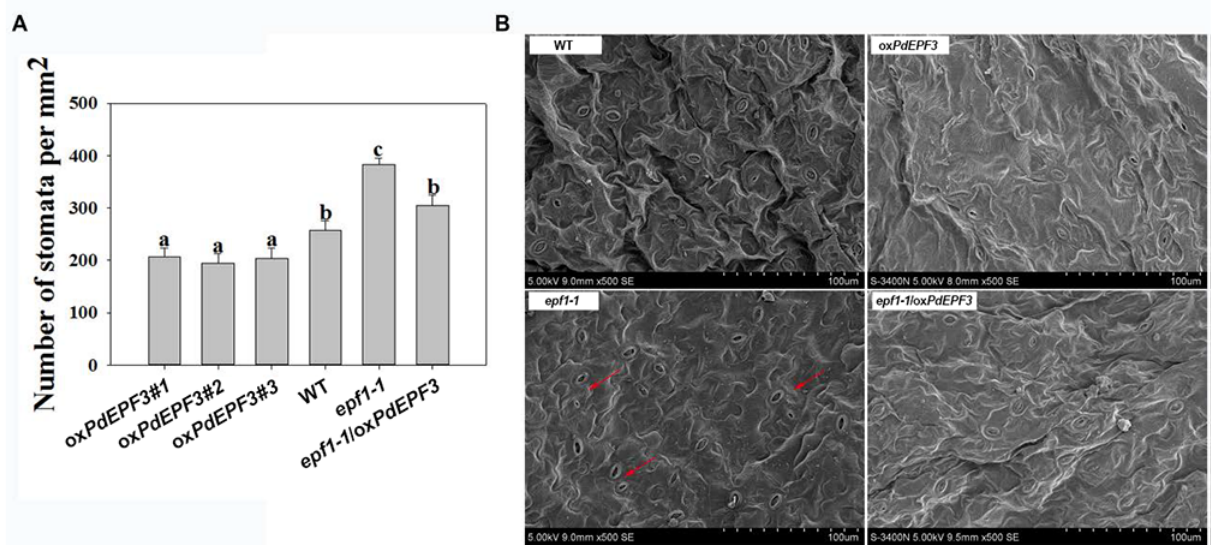
Fig. 6 Effect of PdEPF3 on stomatal density. ( A ) Abaxial stomatal densities in WT, transgenic plants, epf1-1 mutant, and the epf1-1 / ox PdEPF3 complementation line. Different letters indicate significant difference ( p < 0.05). ( B ) Scanning electron micrograph of the abaxial leaf epidermis. Scale bars represent 100 μm.